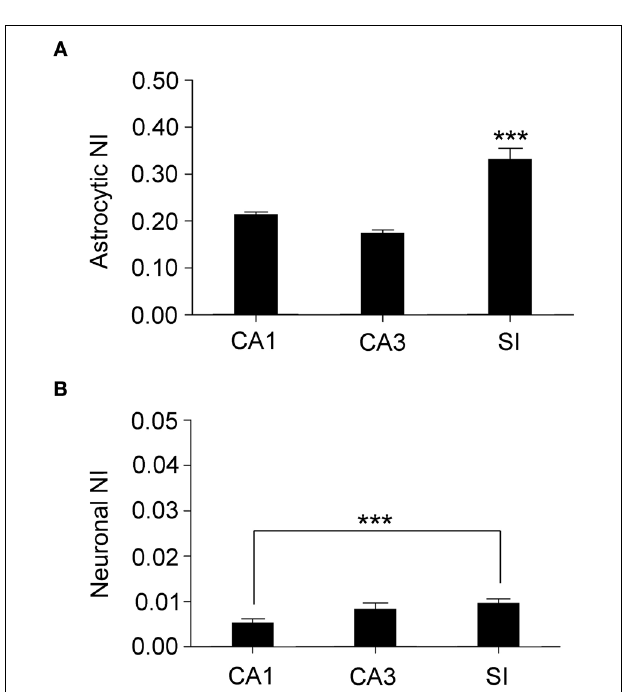
FIGURE 4 | NeuN/eGFP co-localization in hippocampus and neocortex. (A,B) examples of NeuN/eGFP co-localization in stratum pyramidale of CA1 and CA3. Note the presence of cells expressing eGFP in CA3 but not in CA1. (D) percentage of NeuN/eGFP co-localization in stratum oriens (so),